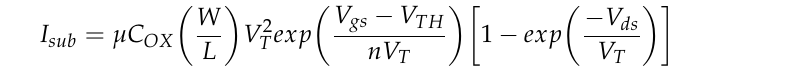
Figure 8. Simulated Δ V gs vs. temperature, for two nMOSs working in their subthreshold region. The schematic is shown in Figure 7, when m = 4, K = 2, between −55 and 125 °C, for TT corner, using a 55 nm CMOS technology. 2.3. Gate Leakage-Based Temperature Sensors (Type III) In 2017, a gate leakage-based temperature sensor was presented at CICC [32]. The temperature sensor stacked a MOSFET between the power supply and the current-starved ring oscillator. The MOSFET’s gate was connected to the power supply. Its drain, source and body were connected together, as node S, which wa s connected to the ring oscillator’s supply node. In this way, the MOSFET’s gate leakage current control led the oscillation frequency of the ring oscillator. One obvious advantage of the gate leakage-based temper- ature sensor proposed in [32] was its energy efficiency, which was seven times better than the state-of-the-art works at its time of publication, as its sensing front-end was based on the gate leakage current, and consumed only 640 pW. Reference [33] relies on both thermal dependent gate-leakage current and subthreshold MOSFETs but is classified into this cat- egory due to its power efficiency. 3. Design Considerations and Challenges for the MOS-Based Temperature Sensors 3.1. The Type of Choice Versus Year of Publication Figure 9 shows the aforementioned three types’ area s versus the year of publication. From the figure, one can observe that type II, the subthreshold MOS-based temperature sensors, have gained popularity over the last 5 years. The reasons for this trend will be explained in the next subsection.